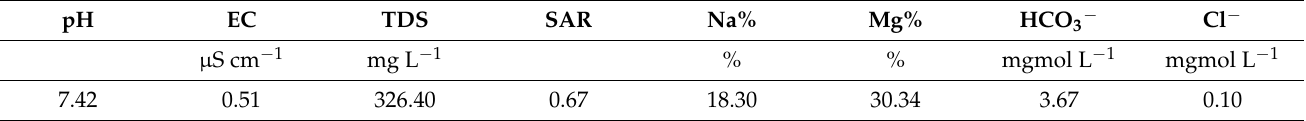
Table 1. Quality parameters of water used for irrigation.